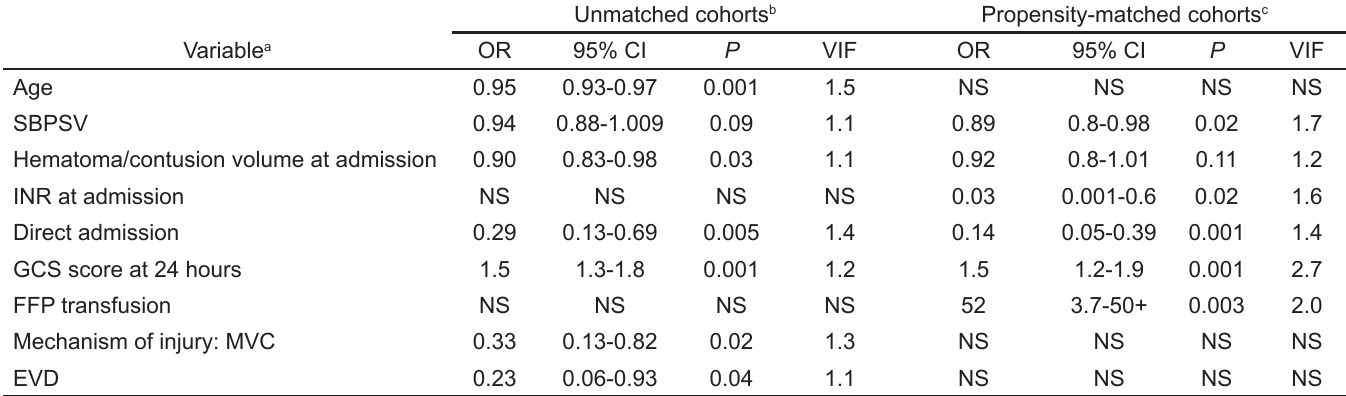
Table 4. Results of stepwise multivariable logistic regressions to measure associations between patient characteristics, clinical course, and discharge location, matched and unmatched